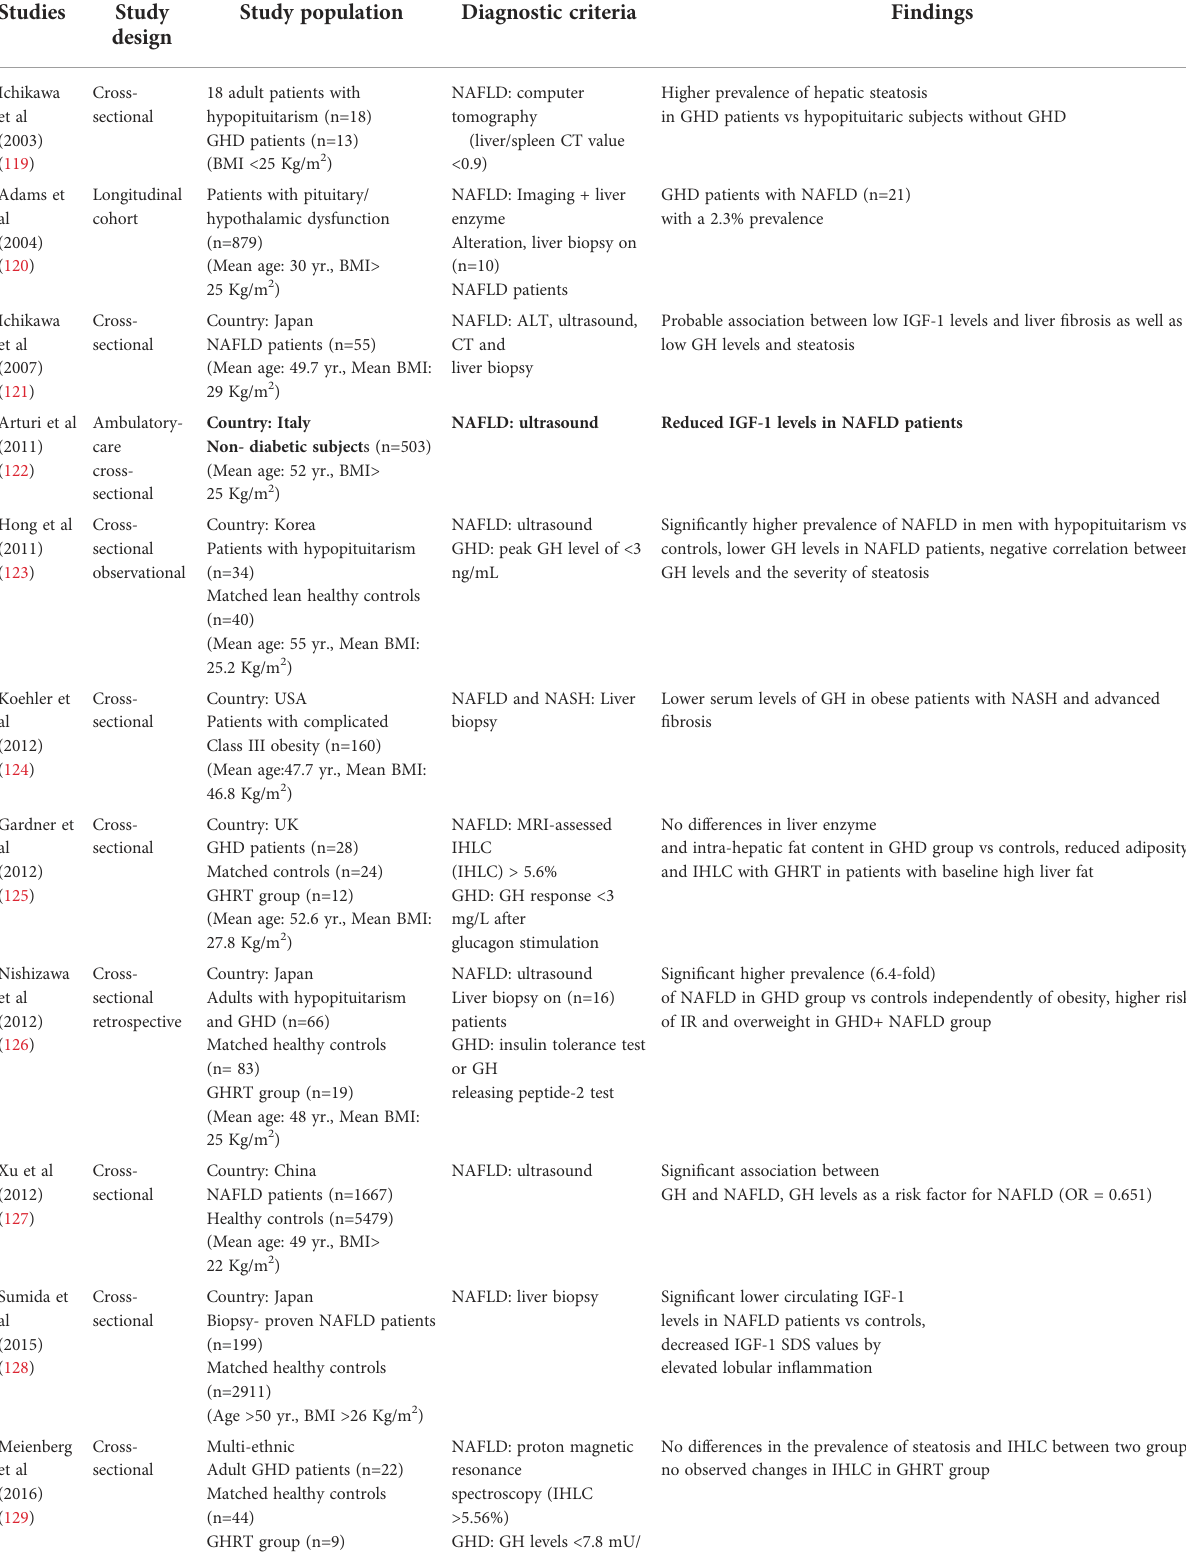
TABLE 2 Studies investigating the risk factors for the development of NAFLD in GHD